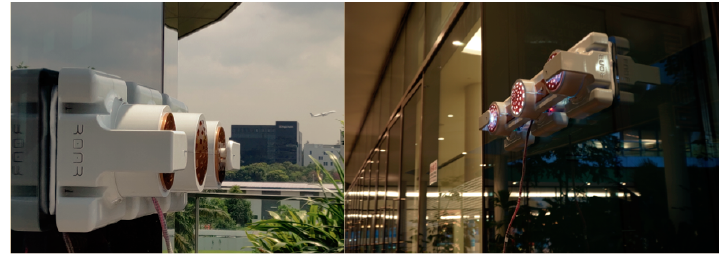
Figure 1. A situation in which the Mantis cleans a glass window panel of a building.